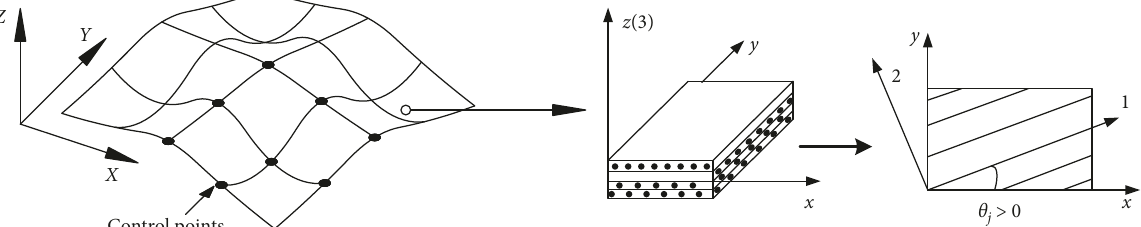
Figure 2: Illustration of the laminate model and coordinate